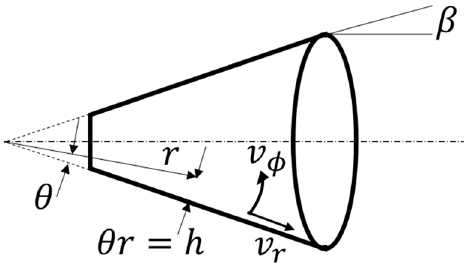
Figure 1. Radial and azimuthal film velocities, along with film thickness h shown inside the conical bell modeled in fixed polar angle ( β ) spherical coordinate